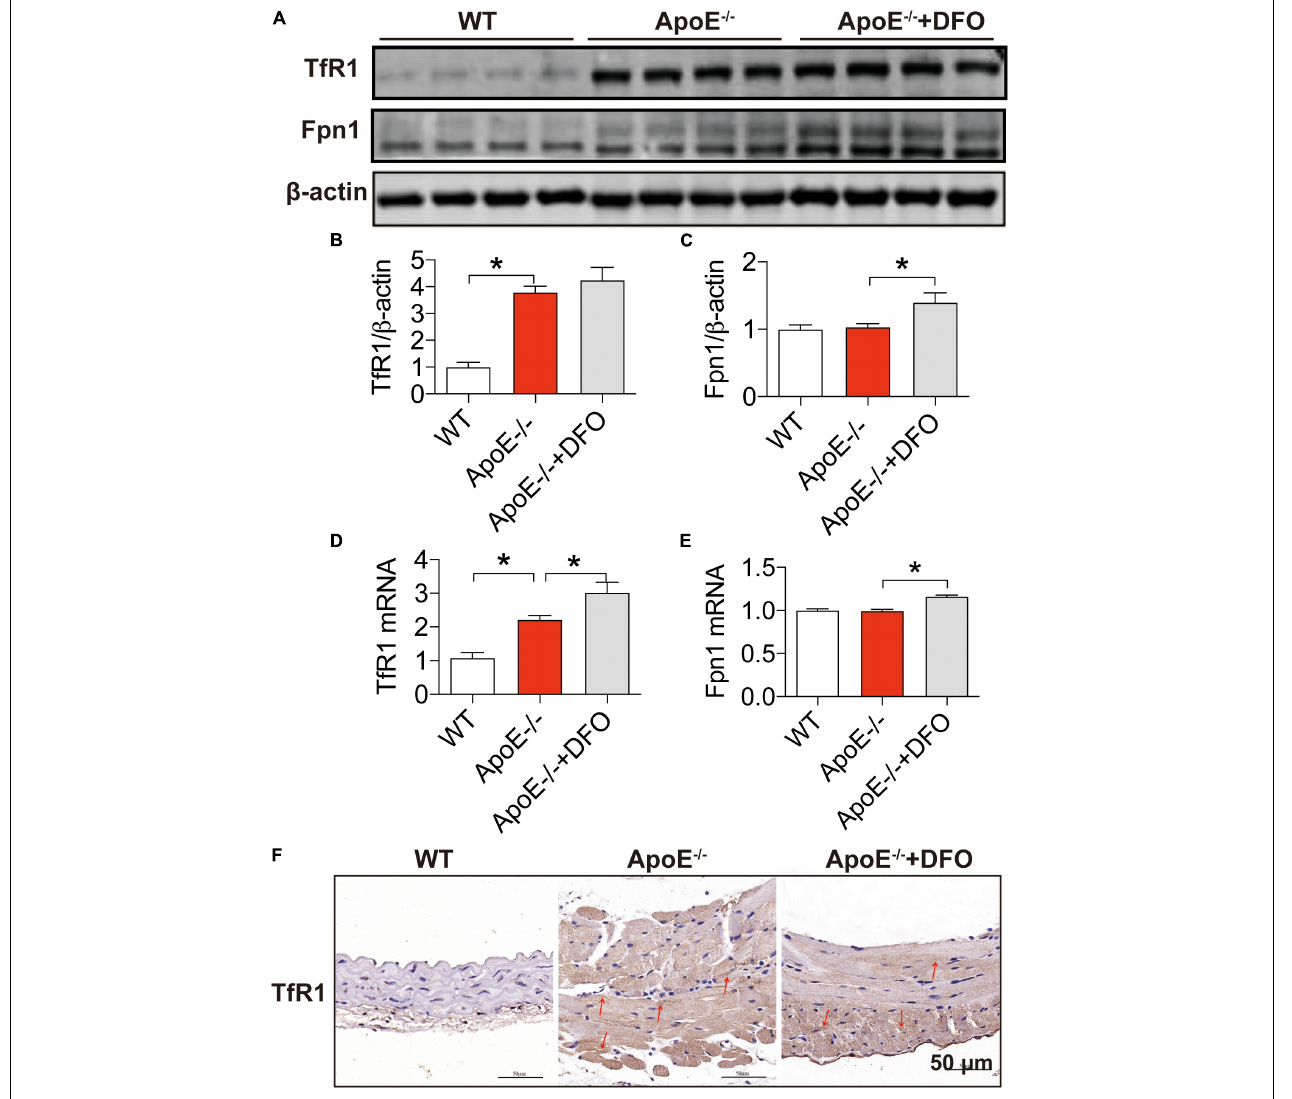
FIGURE 2 | Increased expression of transferrin receptor 1 in the aortic tissues of ApoE deficient mice. The expression of TfR1 and Fpn1 proteins [TfR1, (A,B) ; Fpn1, (A,C) ] and mRNAs [TfR1, (D) ; Fpn1, (E) ] in the aortic tissues were, respectively, determined by Western blot and RT-PCR analysis as described in section “Materials and Methods” in WT ( n = 8; WB: n = 4), ApoE – / – ( n = 8; WB: n = 4) and ApoE – / – + DFO ( n = 8; WB: n = 4) mice, all aged 28 week-olds. Immunohistochemical examination of TfR1 protein expression in the aortic tissues (F) was also conducted in the three groups of mice. The mice in ApoE – / – + DFO group received daily